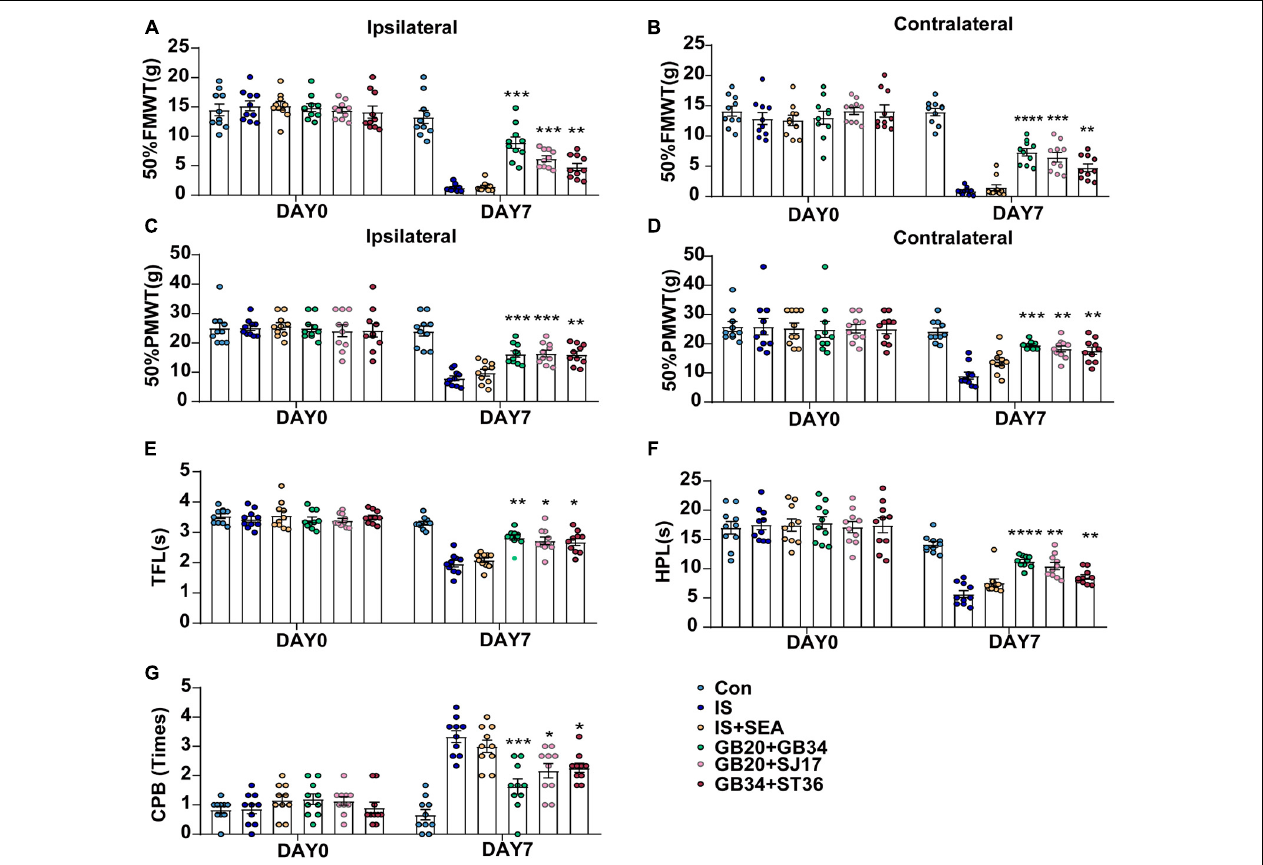
FIGURE 3 | Effect of EA applied at different acupoints on day 0 without IS injection and day 8 (1 day after the 4th IS injection) among Con, IS, IS + SEA, GB20 + GB34, GB20 + SJ17, and GB34 + ST36 groups. Changes in mechanical [50% FMWT (A,B) , and 50% PMWT (C,D) ] and thermal [TFL (E) , HPL (F) , and CPB (G) ] hyperalgesia in dural aCSF- and IS-injected rats that received four times EA at GB20 + GB34, GB20 + SJ17, GB34 + ST36, or non-acupoints every other day ( n = 10). One-way ANOVA followed by post hoc Tukey test. Group values are indicated by mean ± SEM. * P < 0.05, ** P < 0.01, *** P < 0.001, **** P < 0.0001, compared with the IS group. 50%FMWT, 50% facial mechanical withdrawal threshold; 50%PMWT, 50% paw mechanical withdrawal threshold; TFL, tail-flick latency; HPL, hot-plate latency; CPB, cold-plate behaviors; EA, electroacupuncture; IS, inflammatory soup; aCSF, artificial cerebrospinal fluid; GB20, Fengchi; GB34, Yanglingquan; SJ17, Yifeng; ST36,